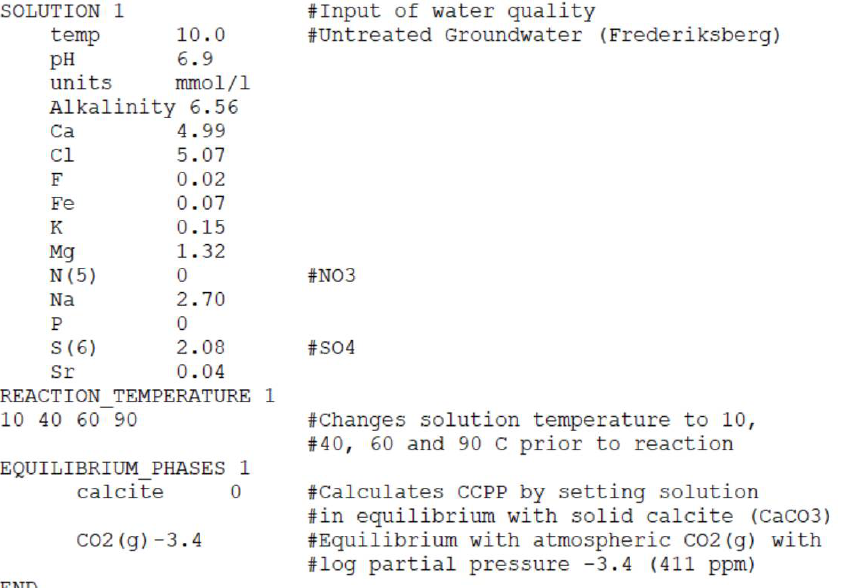
Figure A3. PHREEQC input file for calculating CCPP at 10, 40, 60 and 90 °C for an open system in equilibrium with atmospheric CO 2 (−3.4 is the log of the atmospheric CO 2 partial pressure).